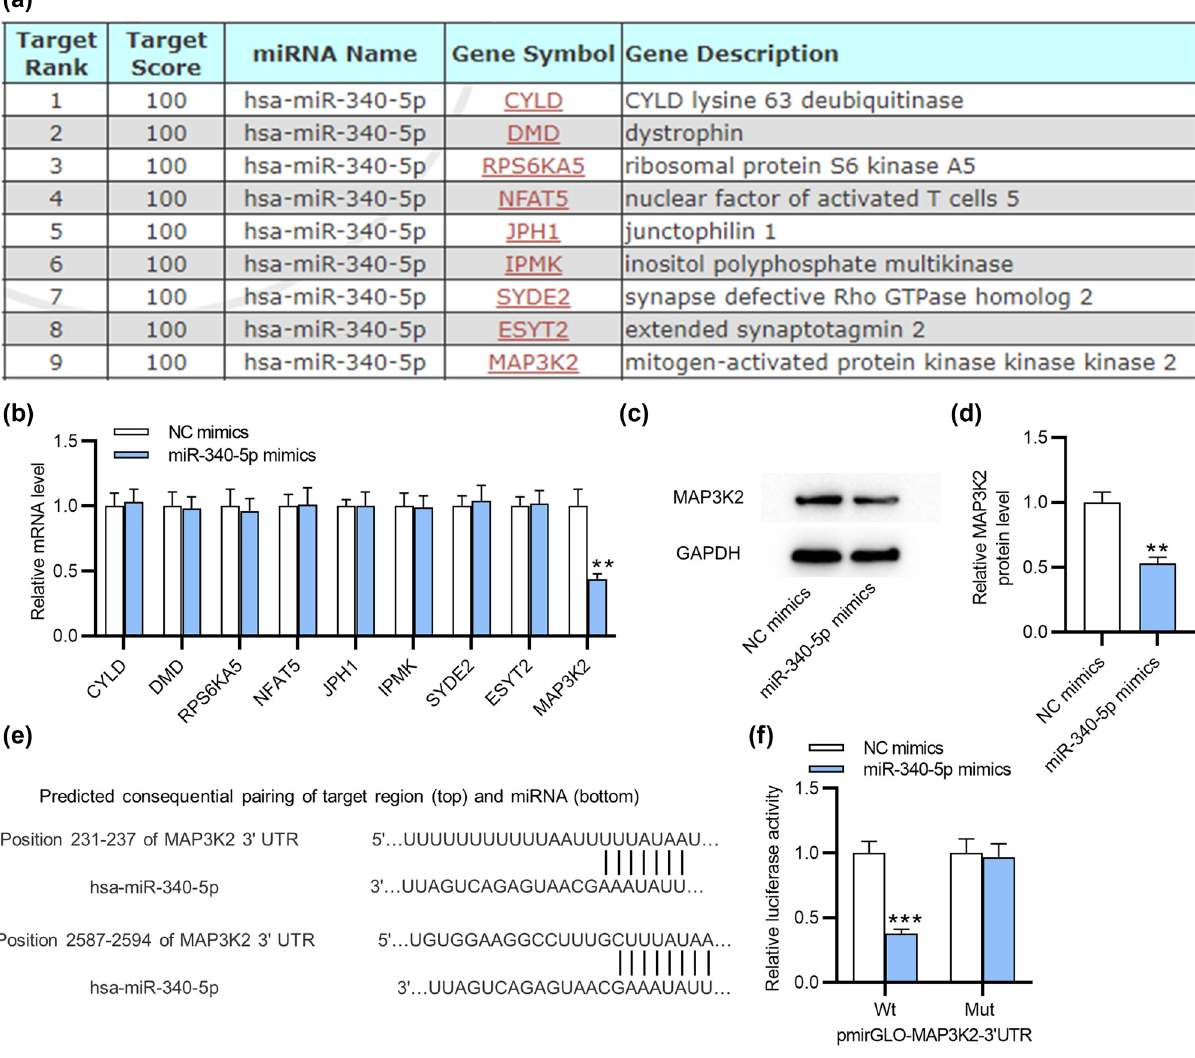
Figure 2: miR - 340 - 5p targets MAP3K2. ( a ) MiRDB was used for screening the downstream targets of miR - 340 - 5p. ( b ) RT - qPCR of the potential mRNA levels in ESCs transfected with miR - 340 - 5p or NC mimics. ( c and d ) Western blotting of MAP3K2 protein expression in ESCs with above transfection. ( e ) Bioinformatics analysis of the potential complementary site of miR - 340 - 5p on MAP3K2. ( f ) The luciferase reporter assay revealed luciferase activity of Wt/Mut pmirGLO - MAP3K2 - 3 ′ UTR in ESCs after upregulating miR - 340 - 5p. ** p < 0.01, *** p <